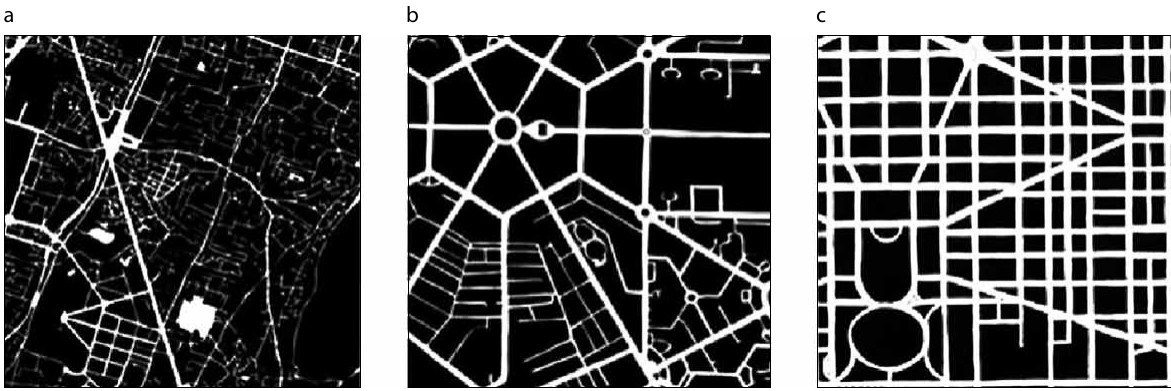
fig. 12. The geometry of streets in Cairo represents a well-defined example of street continuity (jacobs 1993: 218) (a); new Delhi signifies an example of well-defined street widths and patterns (jacobs 1993: 230) (b); Washington DC represents an example of well-defined street patterns (jacobs 1993: 252)